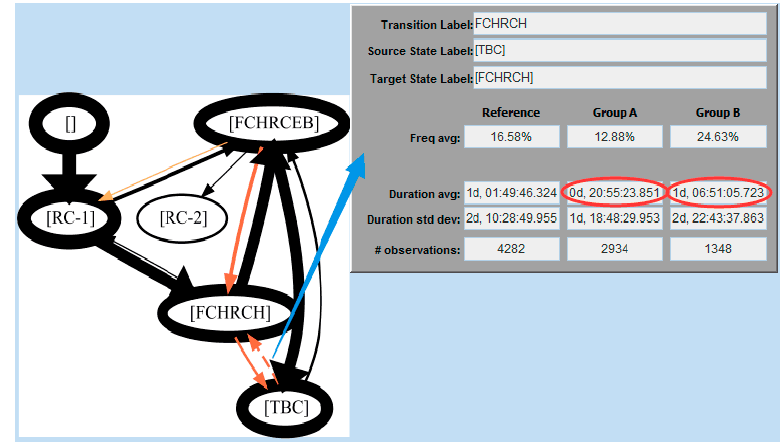
Figure 14. Process comparison of CHS cases with different complaint problems.